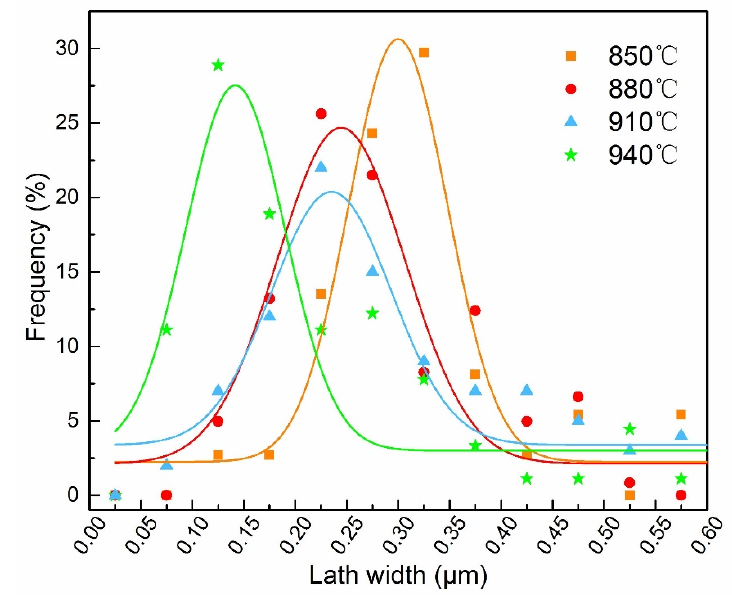
Figure 6. Size distribution of lath width at different austenitizing temperatures.